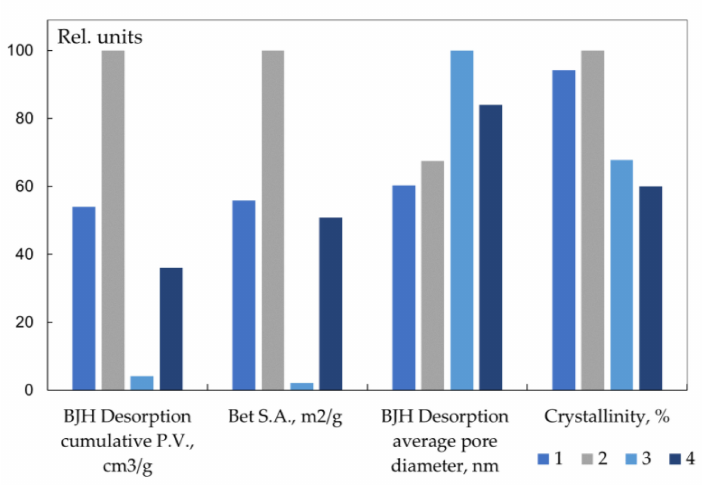
Figure 8. Indicators of pore volume, specific surface area, pore diameter, and crystallinity of chitin samples: original chitin dried in air (1) and in a freeze dryer (2); 3 and 4—reprecipitated chitin dried in air (3) and after freeze-drying (4). Original